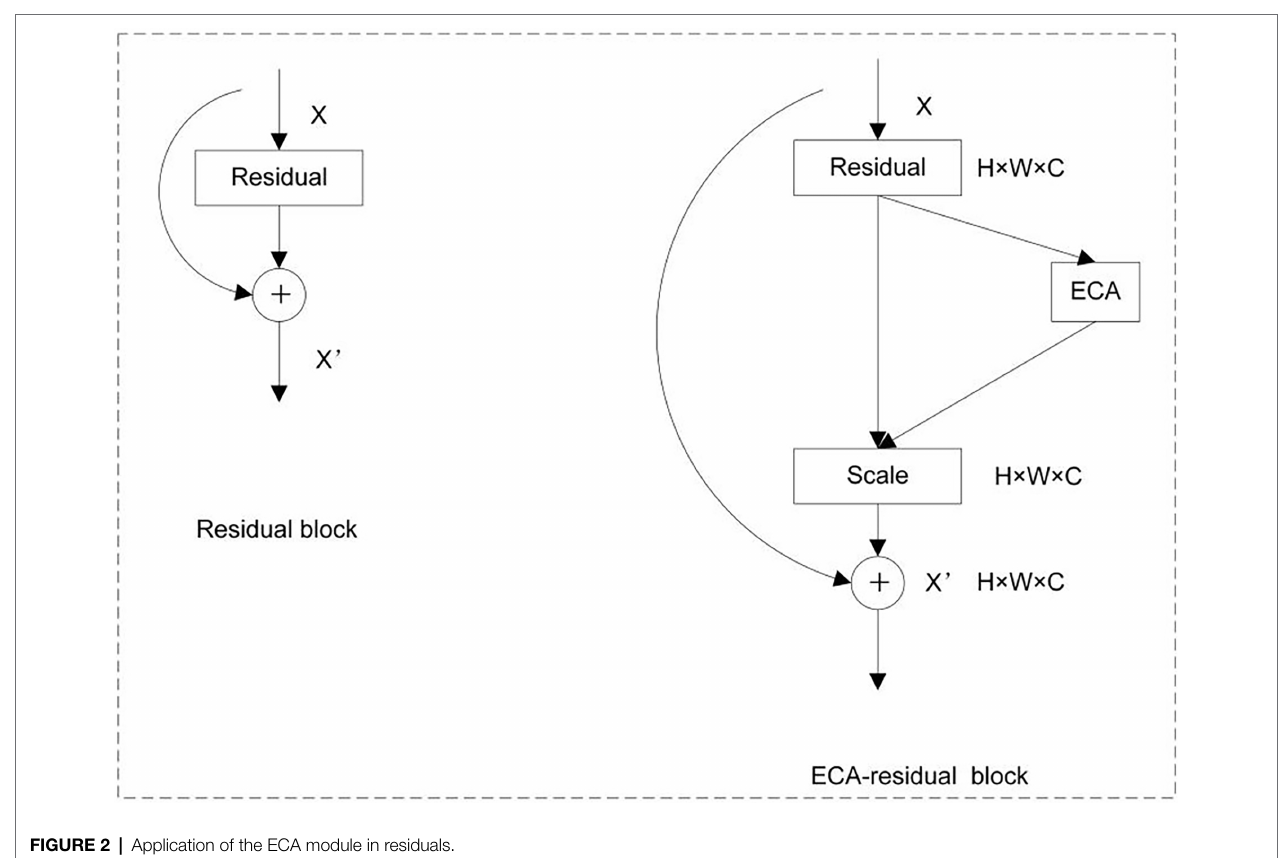
FIGURE 2 | Application of the ECA module in residuals.